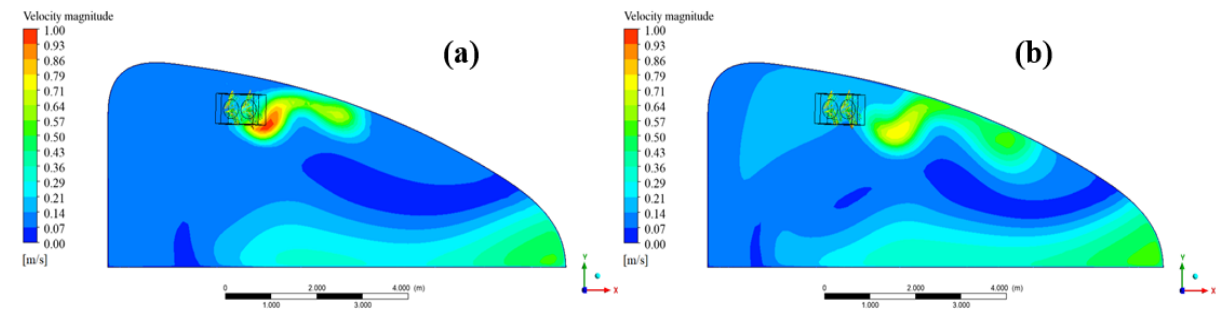
Figure 15. Velocity distribution contours for vertical profiles when the fan swing angle was 60°: plane A ( a ) and plane C ( b ).